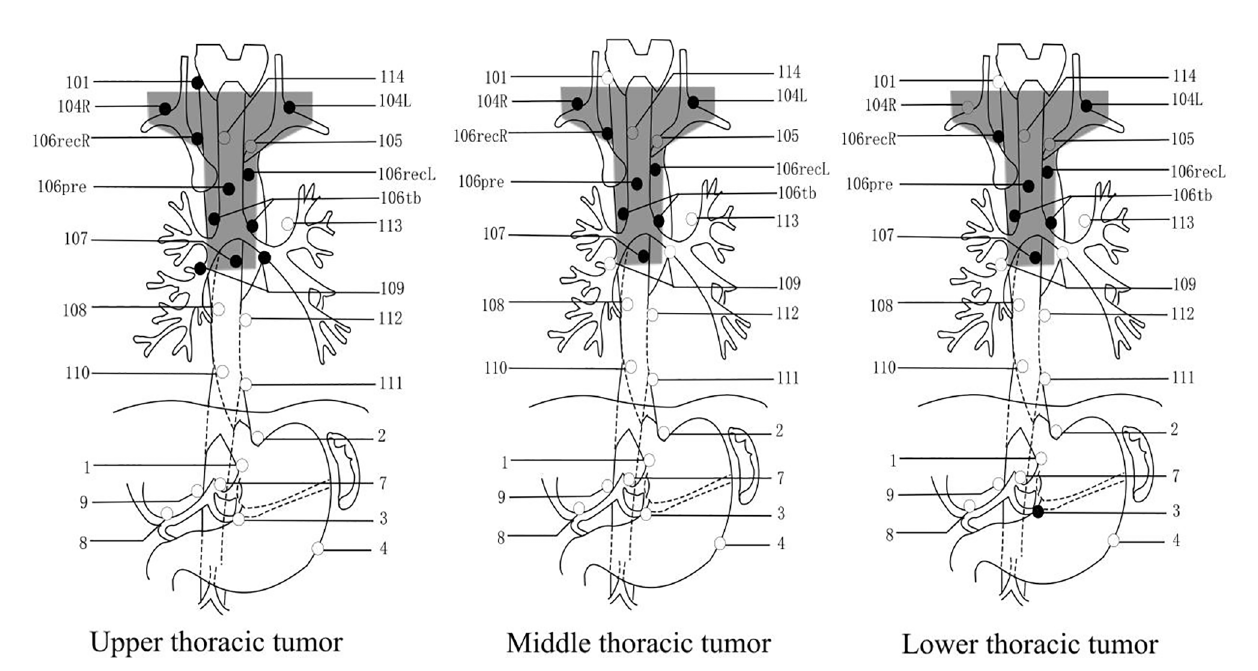
FIGURE 1 | The lymph nodes in different locations with thoracic ESCC. Caption: In the above three pictures, the black dots are the location of the LNR probability of more than 15%. The shaded parts of the box are the proposed T-shaped CTV